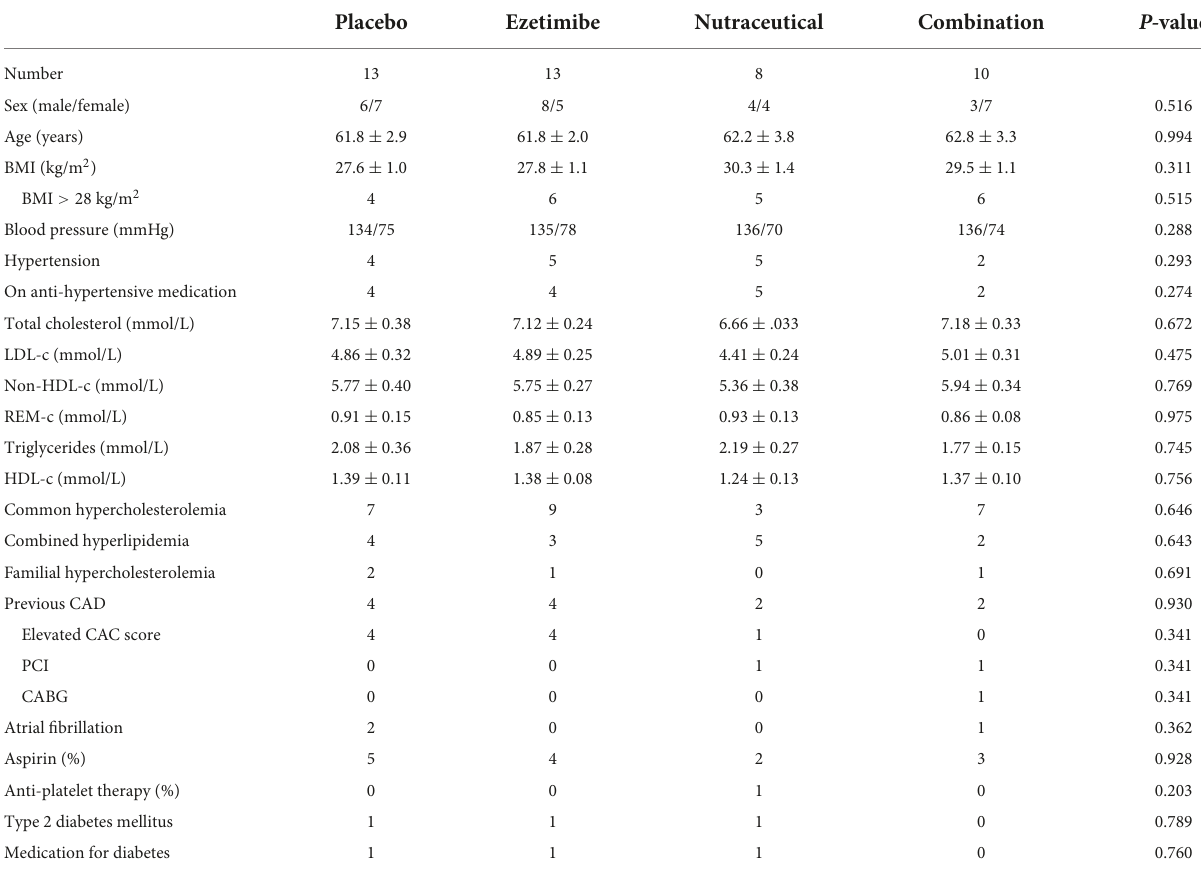
TABLE 1 Baseline characteristics of study